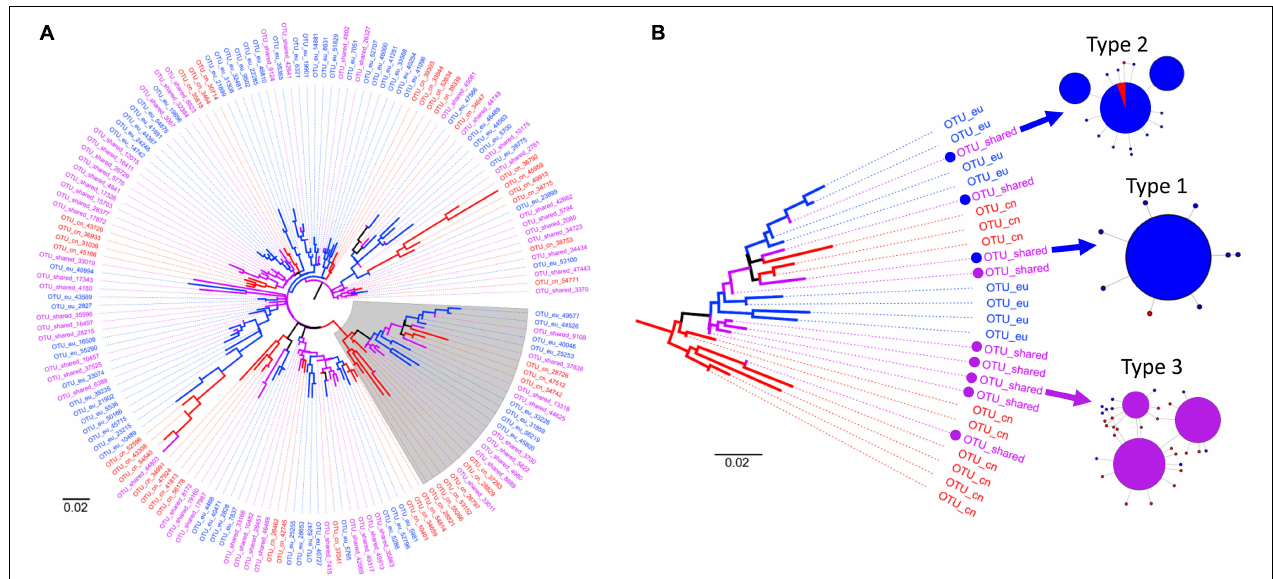
FIGURE 3 | Phylogenetic tree of the tintinnid Tintinnopsis baltica (A) and highlighted sub-clade (B) displaying various branching patterns with different types of shared Swarm OTUs. In Type 1, the representative amplicon of the shared OTUs was exclusively detected in one region but is associated to one or more amplicons from the respective other region. In Type 2, the representative amplicon consists of many reads from one region and only one or very few reads from the respective other region, which are interpreted as methodological artifacts (cp. Figure 2 ). In Type 3, the representative amplicon comprises a considerable number of reads from both